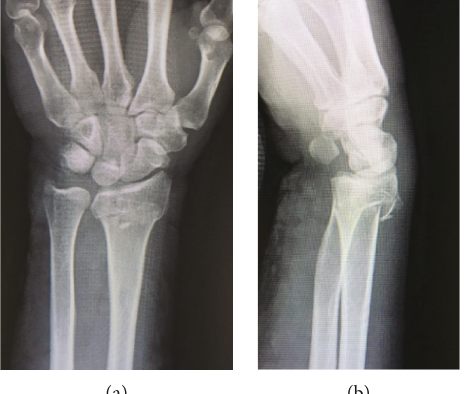
Figure 2: Plain X-ray fi lms on her visit to our hospital. (a) Frontal plain X-ray image. (b) Lateral plain X-ray image. Plain X-ray images showed a distal radius fracture accompanied by dorsal displacement of the distal bone fragment. Due to the skin state, conservative treatment by external fi xation, such as splinting and casting, was di ffi cult. Surgery after improvement of the skin state was considered to be more invasive due to bone union. Therefore, osteosynthesis using a minimally invasive approach was planned.